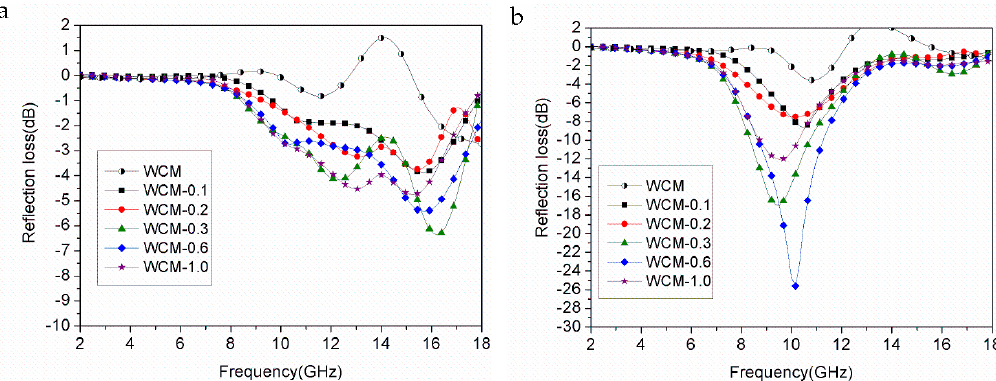
Figure 7. Reflection loss of α-Fe/Fe 3 C/woodceramic nanocomposites as a function of frequency ( a ) 2 mm; ( b ) 3 mm.